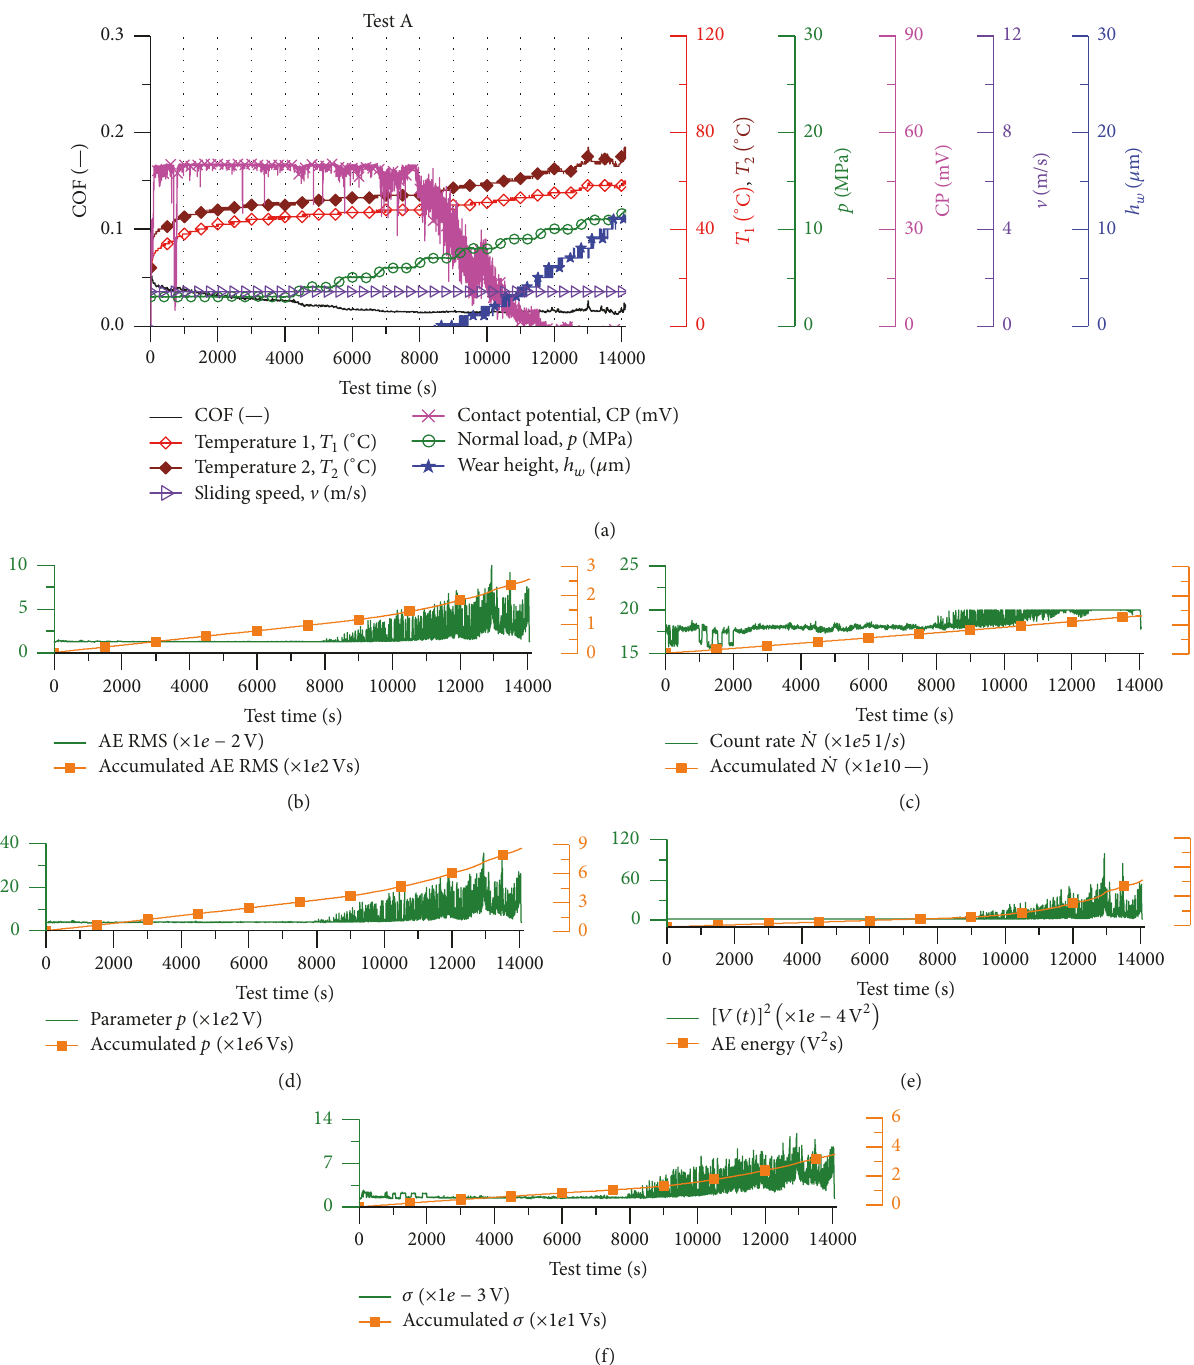
Figure 7: Tribological and correlating AE results of a representative load limit test conducted with the RoD setting.